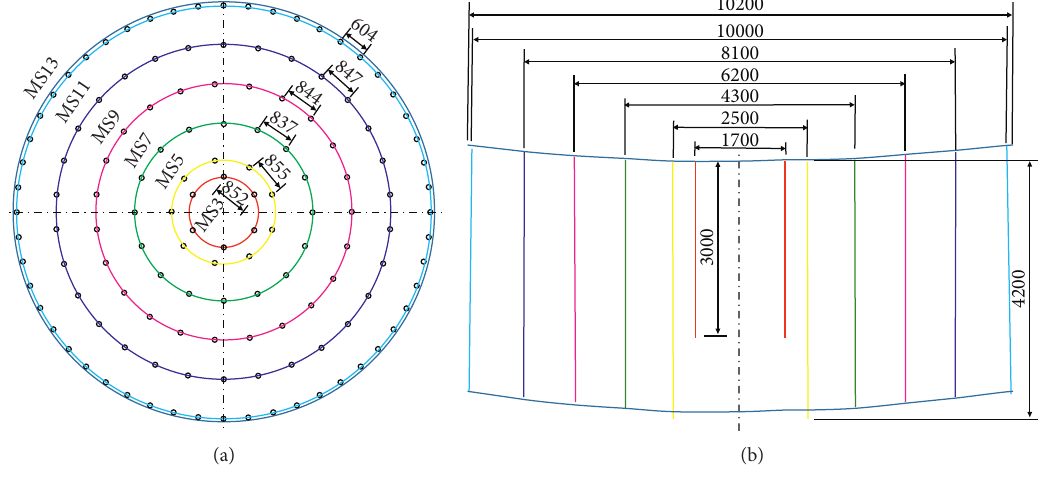
Figure 5: Typical blasting scheme for shaft